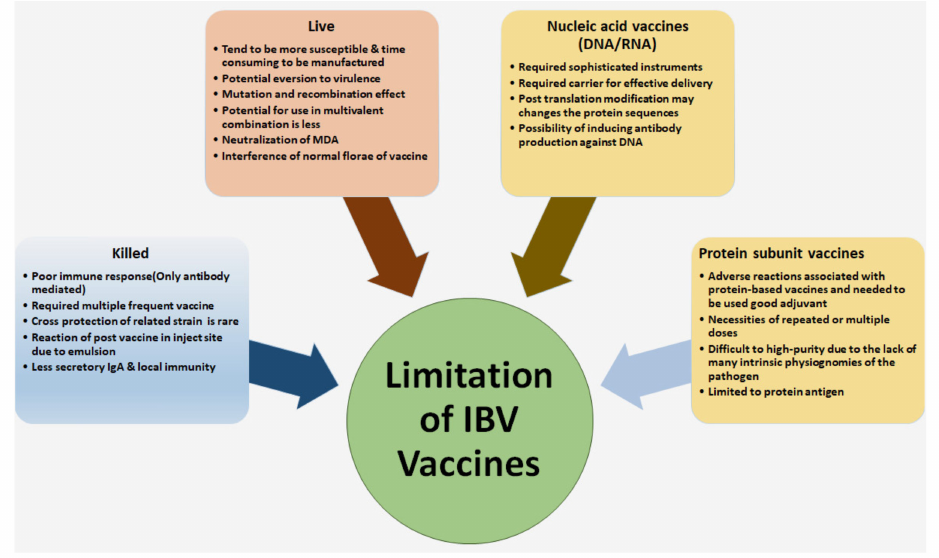
Figure 2. Different types of IB vaccines with limitations correlated with the vaccine strategy and